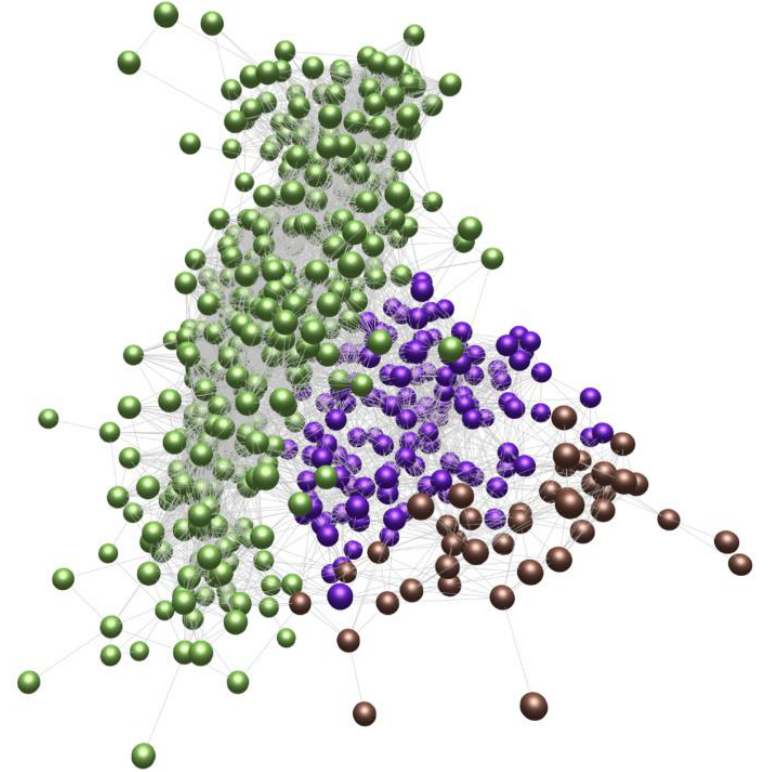
Figure 1. BioLayoutExpress3D example of analysis of the similarity (edge) between symptom profiles (vertex) [19].